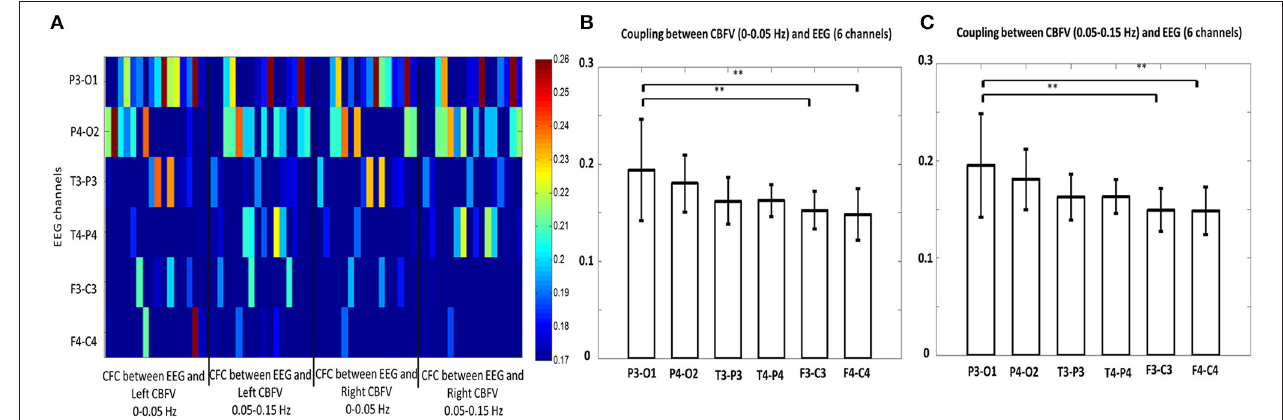
FIGURE 4 | (A) Phase-amplitude cross-frequency coupling (PAC) between bilateral CBFVs and EEG of six channels (F3-C3, T3-P3, P3-O3, F4-C4, T4-P4, P4-O2). The x axis represents the bilateral CBFV frequency bands (0–0.05 and 0.05–0.15Hz), and the y axis represents six EEG channels (F3-C3, T3-P3, P3-O1, F4-C4, T4-P4, P4-O2). One point represents one patient, with red color indicating strong PAC and blue color indicating weak PAC. In general, P3-O1 and P4-O2 show brighter belts than the other four EEG channels. (B) Statistical comparison of mean PAC between CBFV (0–0.05Hz) and EEG of 6 channels. (C) Statistical